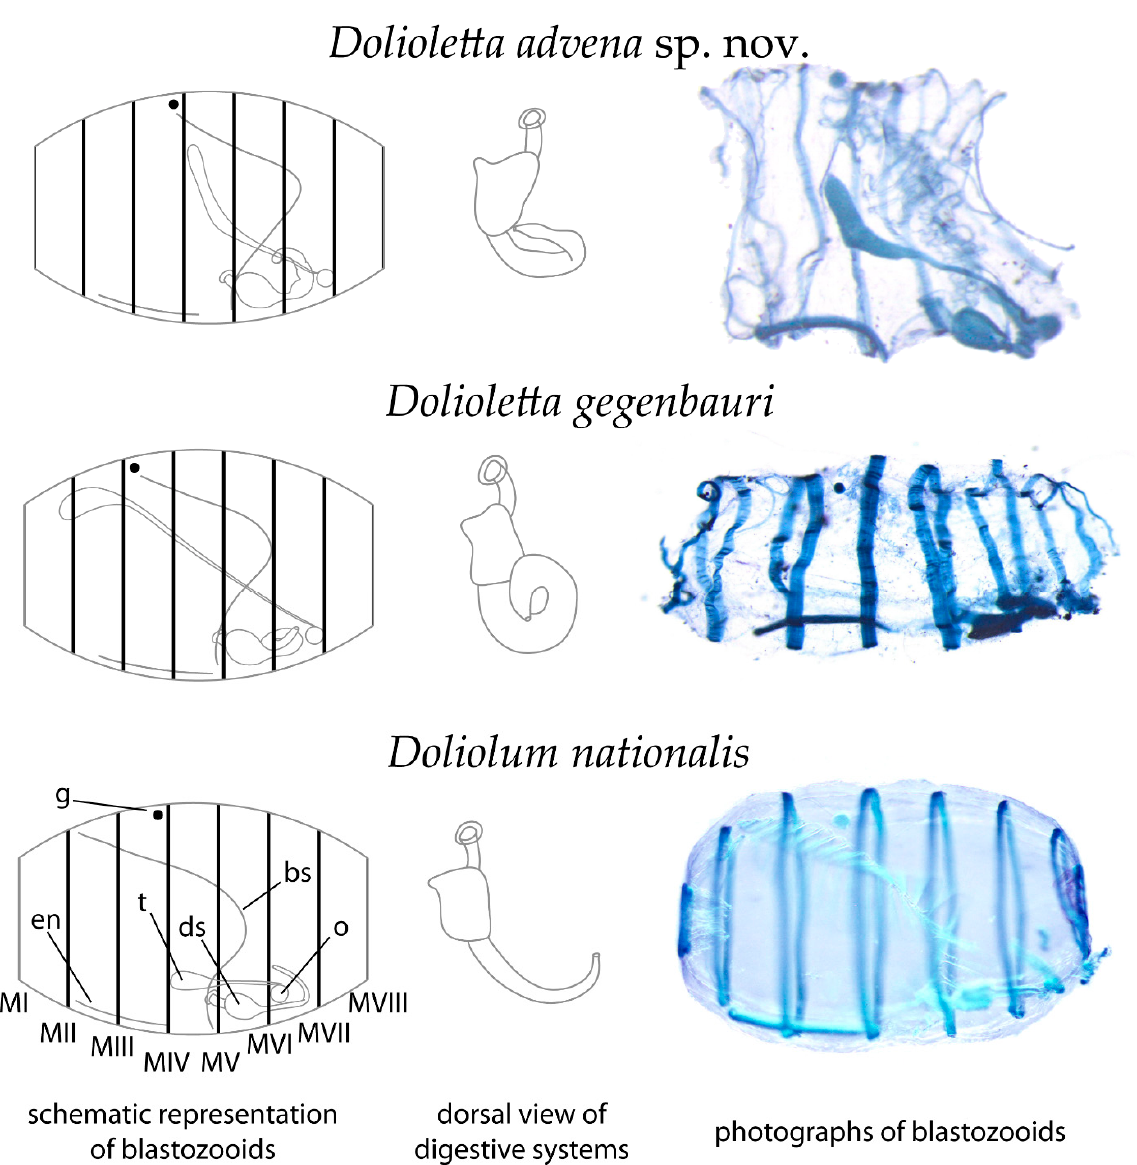
Figure 6. Schematic representation of blastozooids of three doliolid species, Dolioletta advena sp. nov. (holotype), Dolioletta gegenbauri and Doliolum nationalis , ventral view of their respective digestive systems and photographs of Janus Green stained blastozooids. MI to MVIII—muscle bands, en— endostyle, g—ganglion, t—testis, ds—digestive system, bs—branchial septum, o—ovary.